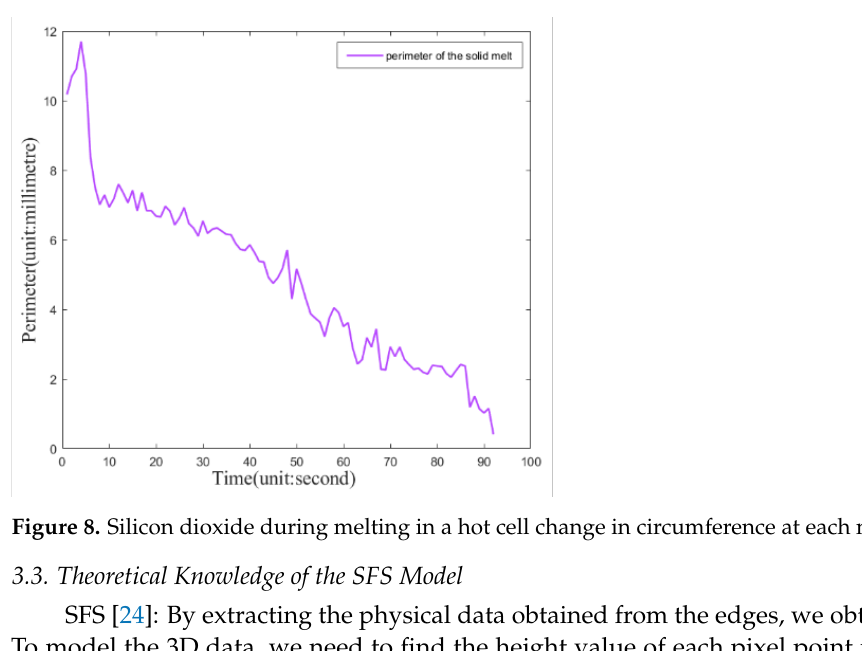
Figure 7. Silicon dioxide during melting in a hot cell plot of area change at each moment.